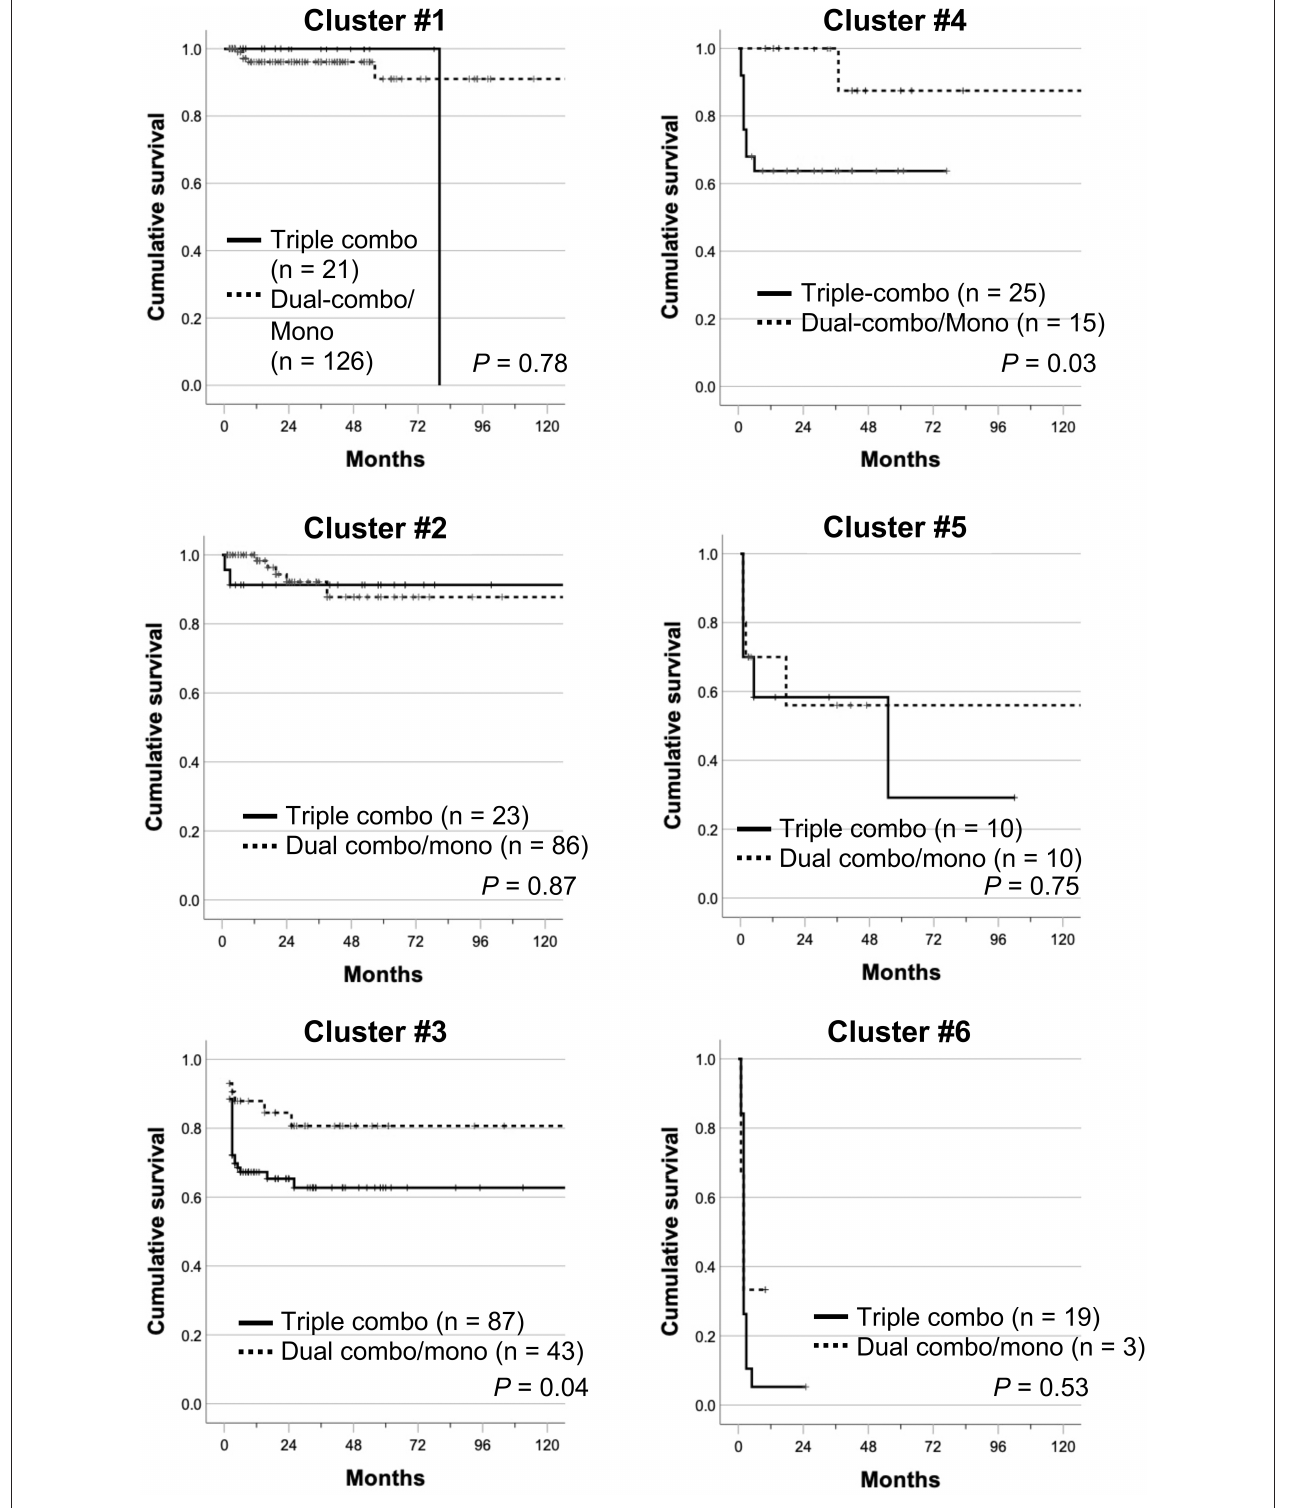
FIGURE 4 | Cumulative survival rates of patients treated with initial triple-combo therapy and those treated with initial dual-combo therapy or monotherapy in each cluster (clusters #1–#6). Cumulative survival rates were compared using Kaplan–Meier analysis, and the log-rank test was used to test for significant differences between two